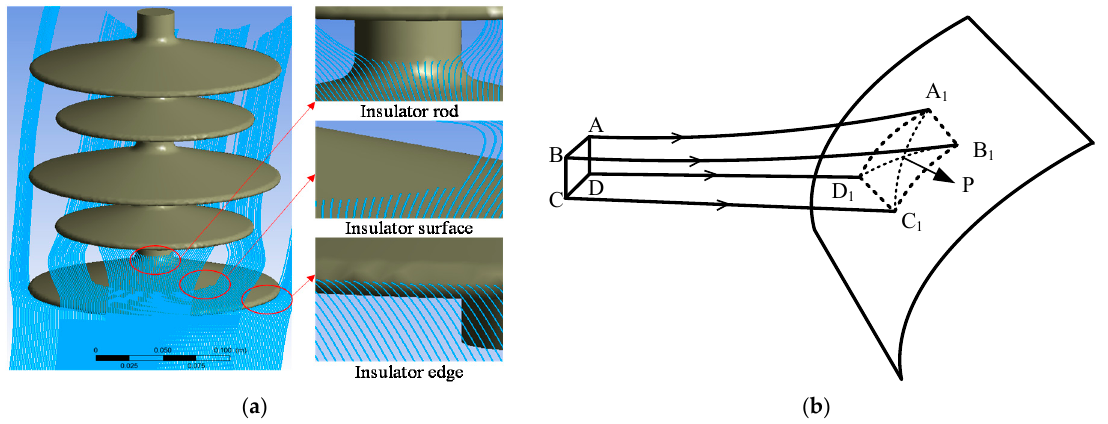
Figure 2. The calculation of the local collision efficiency (LCE) of water droplets. ( a ) The flow around of water droplets at three positions on the insulator (wind speed ( U ) = 8 m/s, medium volume diameter (MVD) = 50 μ m); and ( b ) the relative position of water droplets.